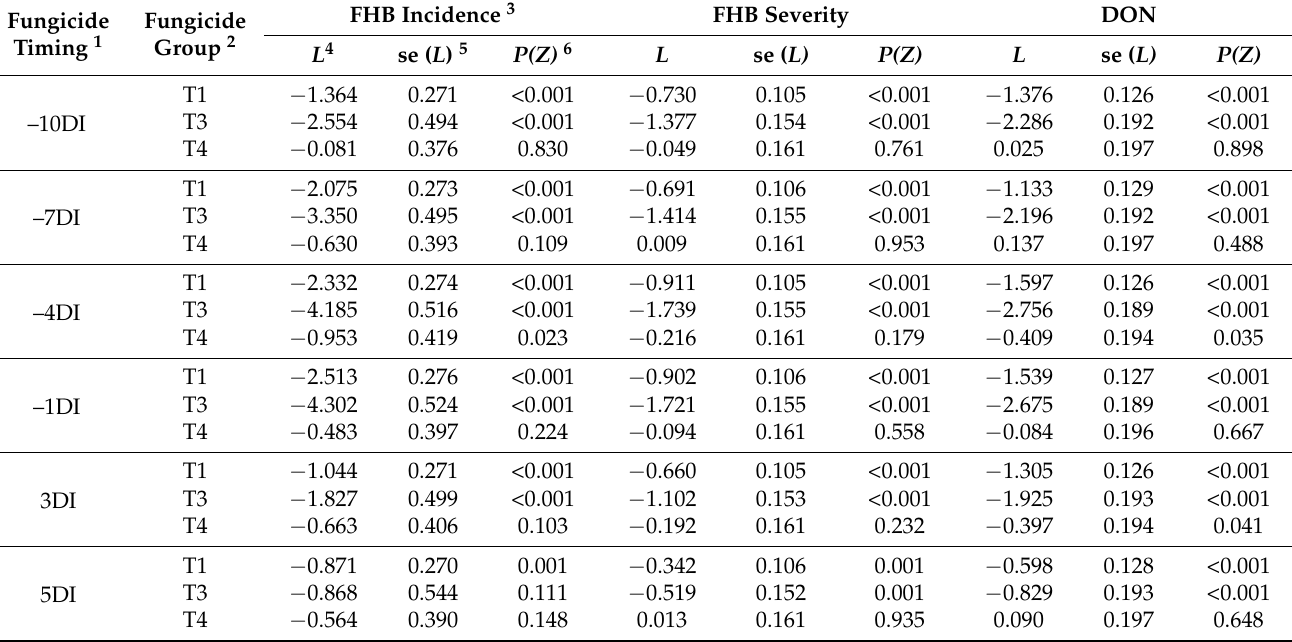
Table 5. Effect size ( L ) and corresponding statistics estimated by GLMMs of the control of Fusarium head blight (FHB) incidence, FHB severity, and DON concentration with fungicides of different groups applied based on days before or after artificial inoculation of wheat spikes with Fusarium graminearum